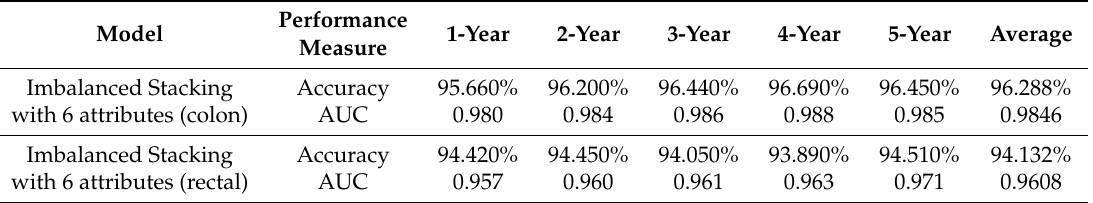
Table 7. Accuracy and AUC results for the imbalanced Stacking models with six attributes for colon and rectal